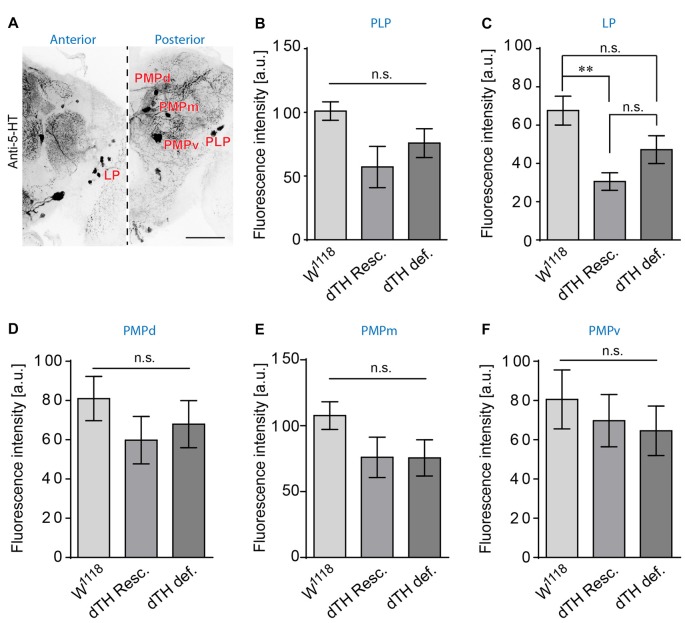
DA deficiency does not increase 5-HT IR in somata of 5-HT-producing neurons. (A) 5-HT immunoreactive neurons in the anterior (left, LP) and posterior medial (right, PMPd, PMPm, PMPv) and PLP in w1118. Scale bars: 50 μm. (B–F) DA-deficient flies do not show increased 5-HT somatic IR when compared to w1118 or genomic dTH-rescue flies (ANOVA with Bonferroni correction, n < 6). n.s.: p > 0.05; **p < 0.01.